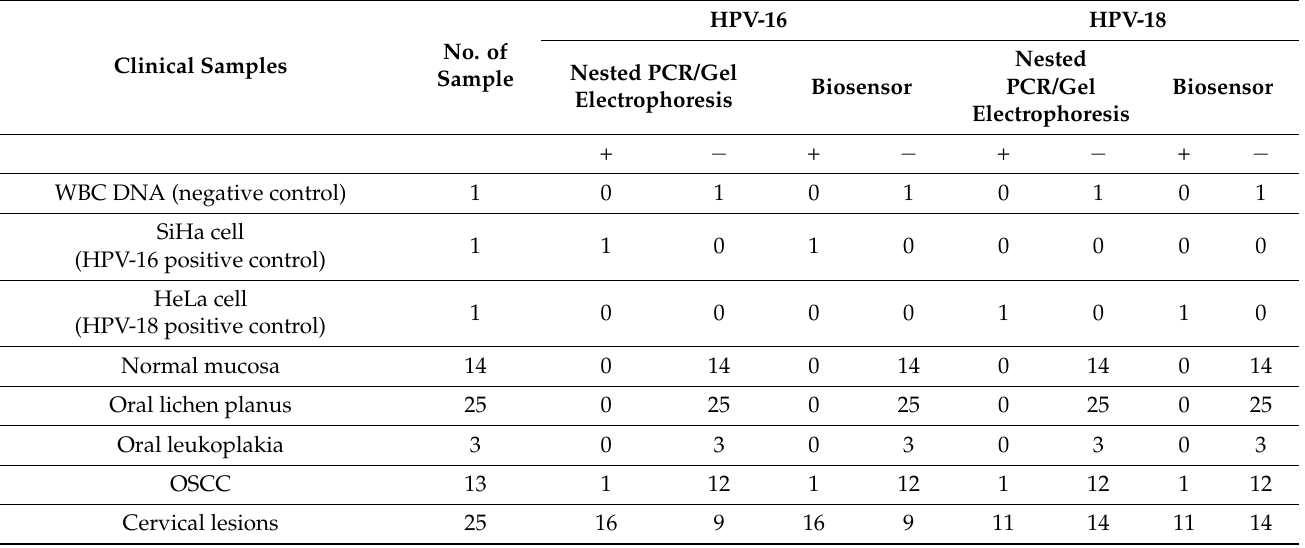
Table 3. Comparison of HPV-16 and HPV-18 detection in clinical samples using nested PCR/gel